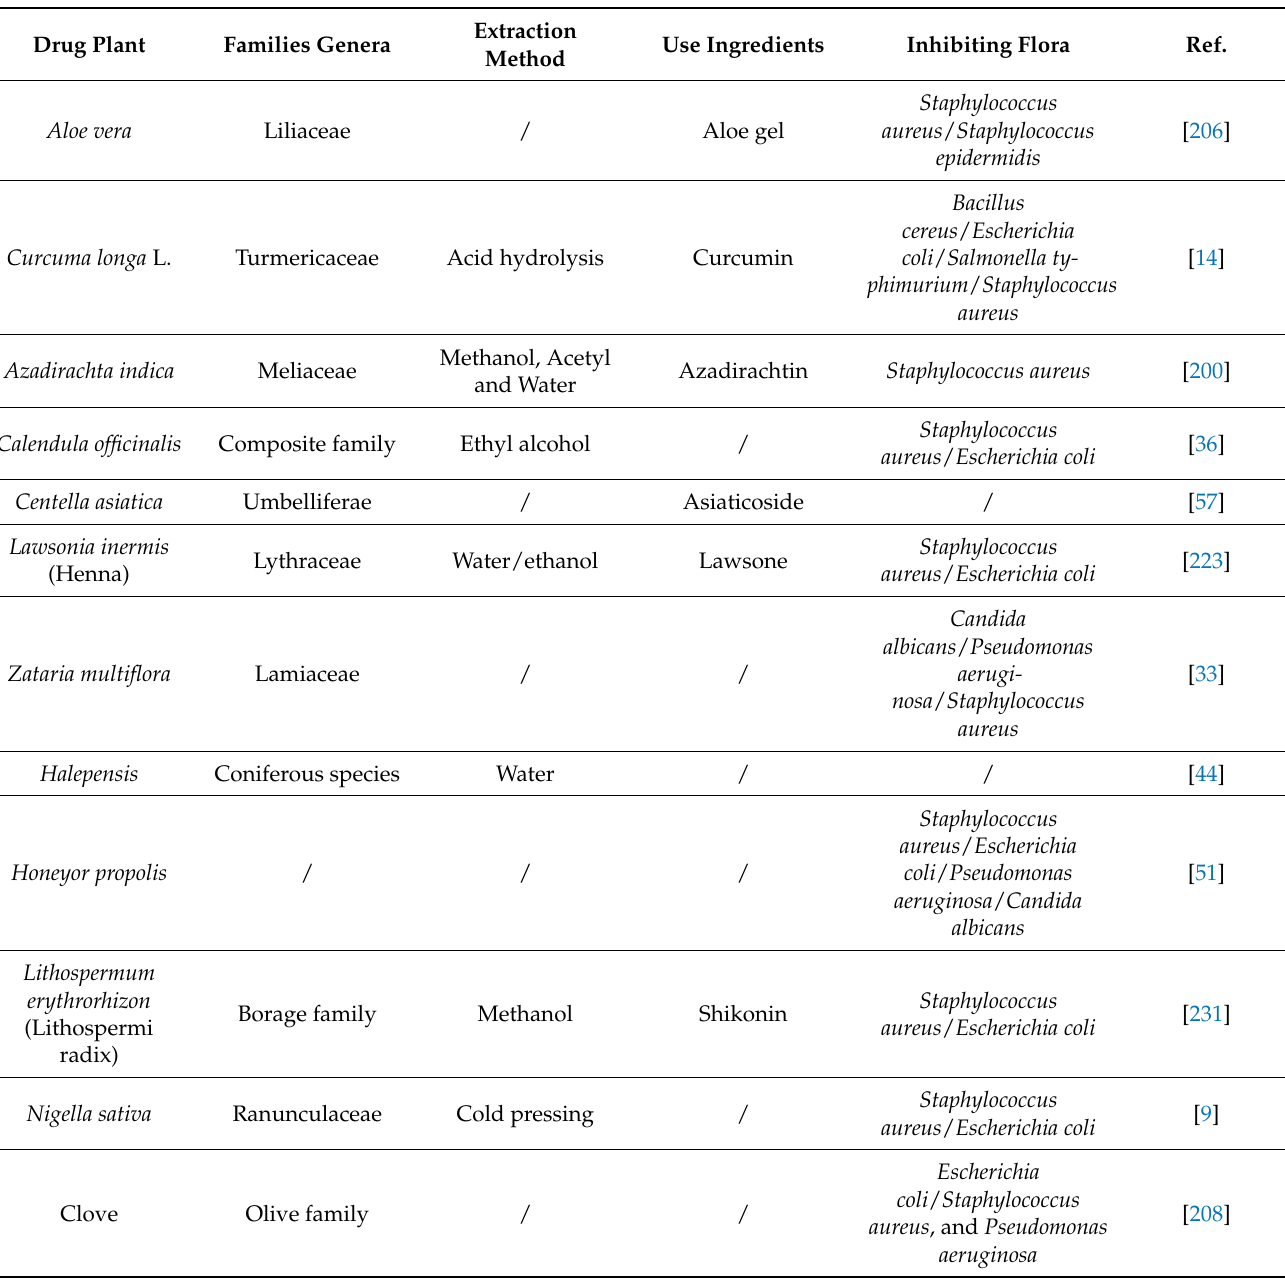
Table 5. Antibacterial types of herbal